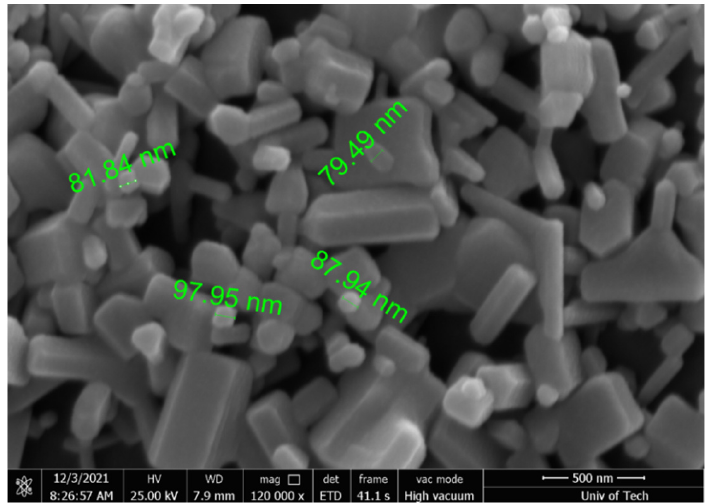
Figure 4. Field Emission scanning electron microscope (FESEM) image of green-synthesized ZnO NPs.